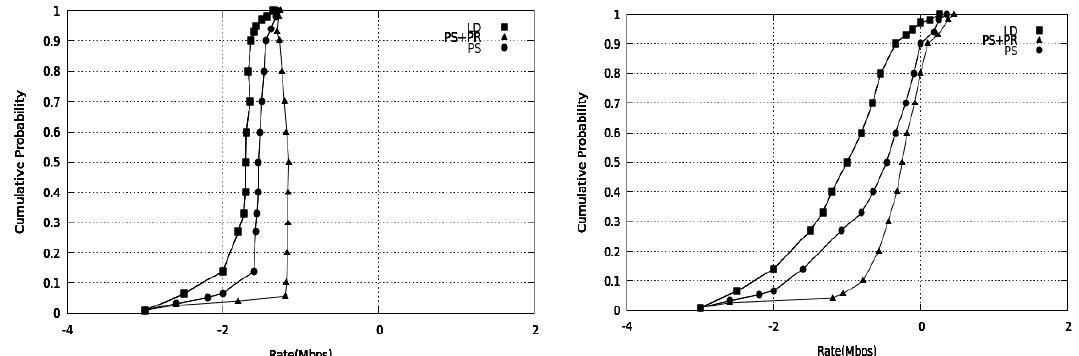
Figure 2. Throughput gain using different schemes with 𝜼 = 𝟏/𝟒 and 𝜼 =